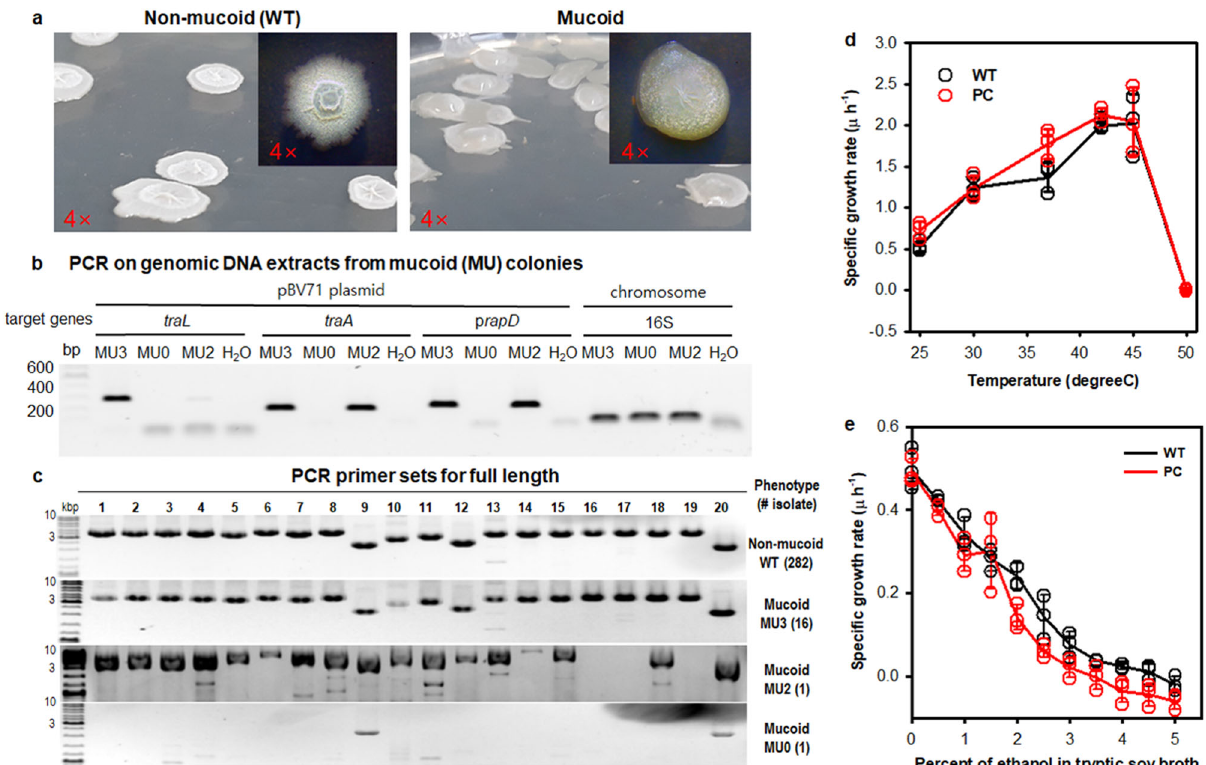
Fig. 1 Conversion of non-mucoid to mucoid phenotype of Bacillus velezensis strain GH1-13. a Colony morphology of non-mucoid (WT) and mucoid variants. WT strain GH1-13 shows as an irregular round, opaque white colony with umbonate elevation and wrinkled surface during cultivation on TSA and R2A plates at 25 °C, whereas mucoid variants form translucent white, convex, mucous colonies. b PCR screening of mucoid variants detected using genomic DNA extracts as templates and three plasmid target loci ( traL , traA , and p rapD ) and a 16S ribosomal RNA gene segment as a genomic DNA control. c Evaluation of mucoid variants by PCR of the full-length plasmid genome is described in the “ Methods ” section. d Effects of temperature on the speci fi c growth rate observed by measuring the OD600 during an early exponential phase in tryptic soy broth with aeration (180 rpm). e Effects of ethanol concentration (%, v/v) on the speci fi c growth rate of cells in tryptic soy broth at 25 °C with aeration. n = 3 independent experiments (Supplementary Data 3). The mean and standard deviation (error bar) are plotted for all